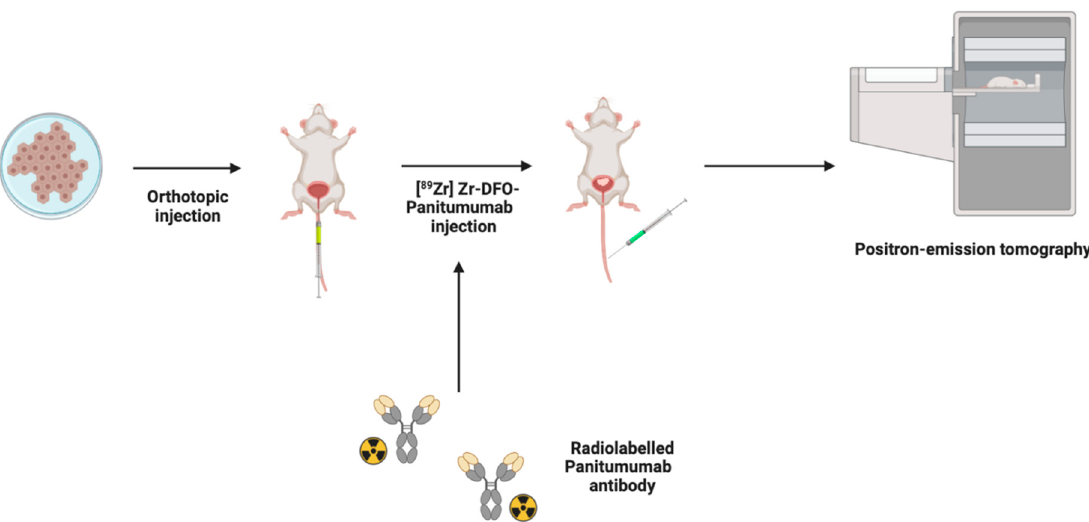
Figure 3. Positron emission tomography (PET) method in an intravesical murine model of BCa in which EGFR-expressing BCa cells are inoculated into the mouse bladder wall. Antibodies are conjugated and radiolabeled producing [ 89 Zr] Zr DFO-panitumumab, which was administered intravenously, and mice were imaged 72 h later. Figure prepared with BioRender (biorender.com, accessed on 1 February 2023).